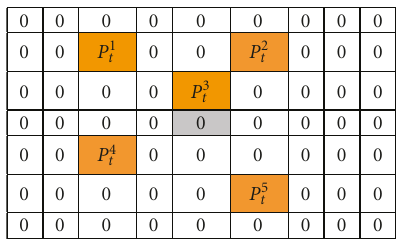
Figure 1: An example of GHT image at time t .